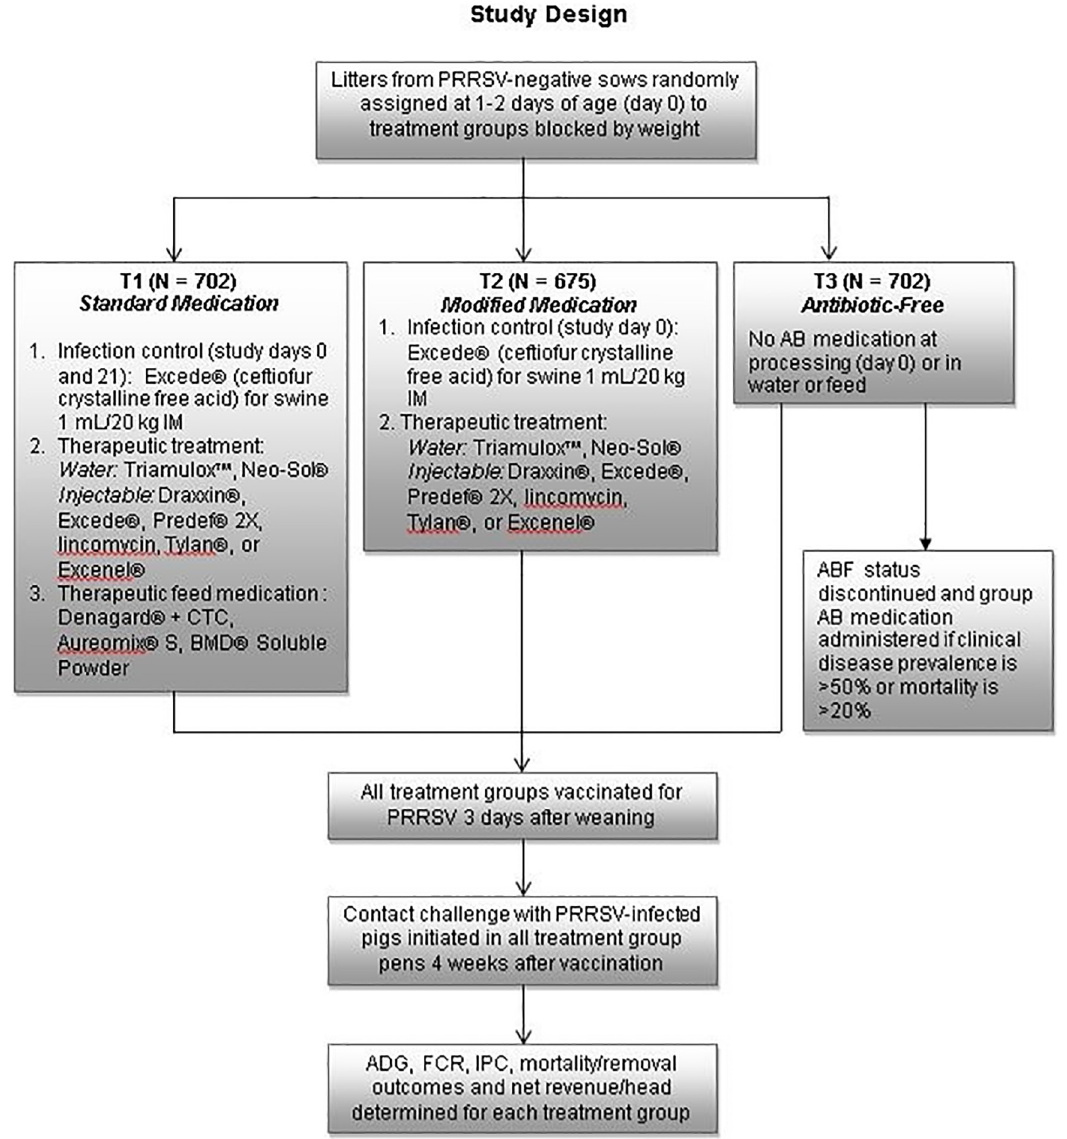
Fig 1. Study design. Outcomes were compared for pigs managed with standard AB medication (T1), modified AB medication (T2), or an antibiotic-free (ABF) regimen (T3). AB = antibiotic; ADG = average daily gain; FCR = feed conversion ratio; IPC = Individual Pig Care; PRRSV = porcine reproductive and respiratory syndrome